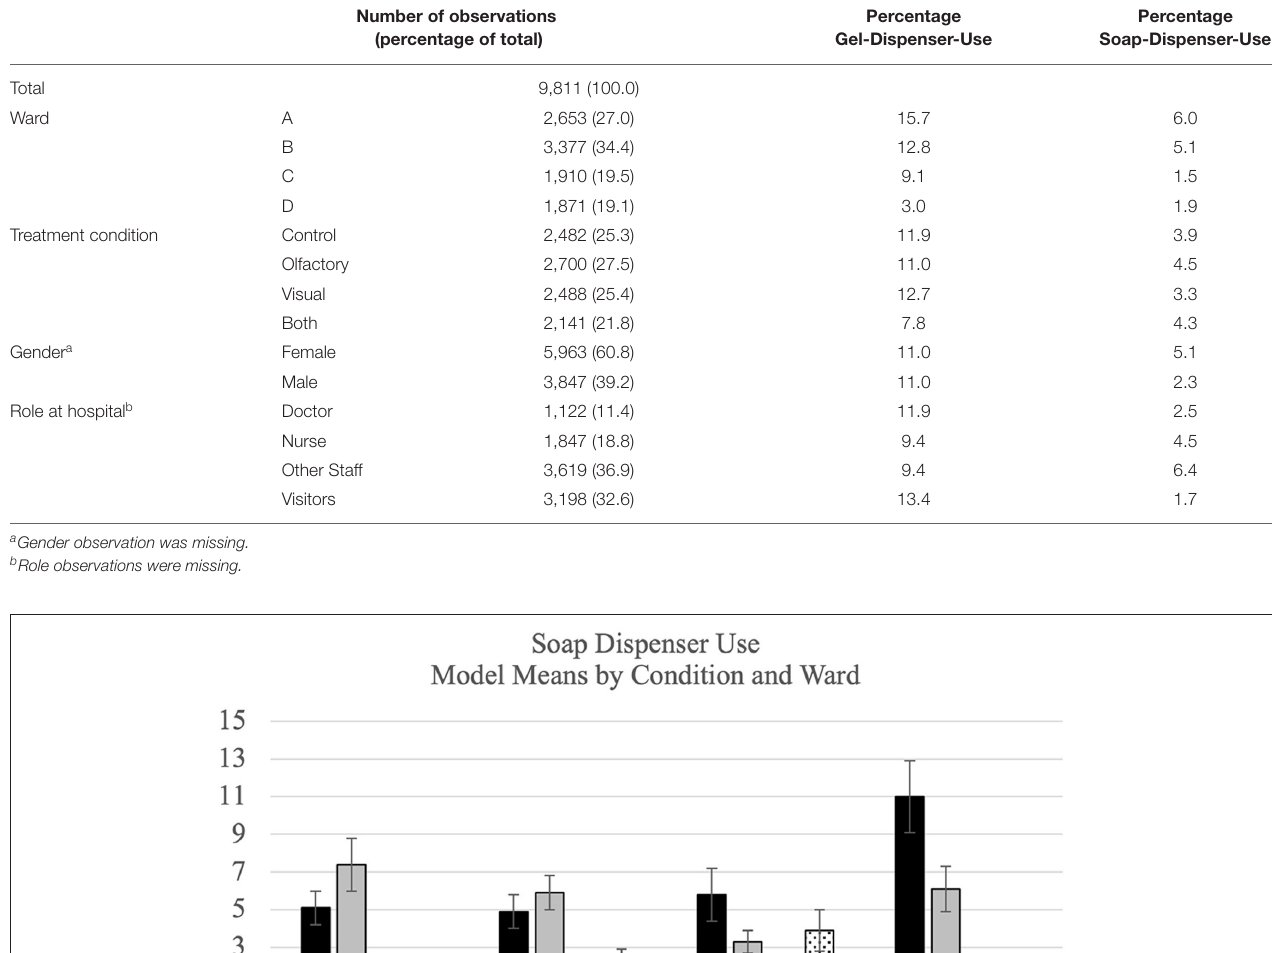
Number of observations (percentage of total)